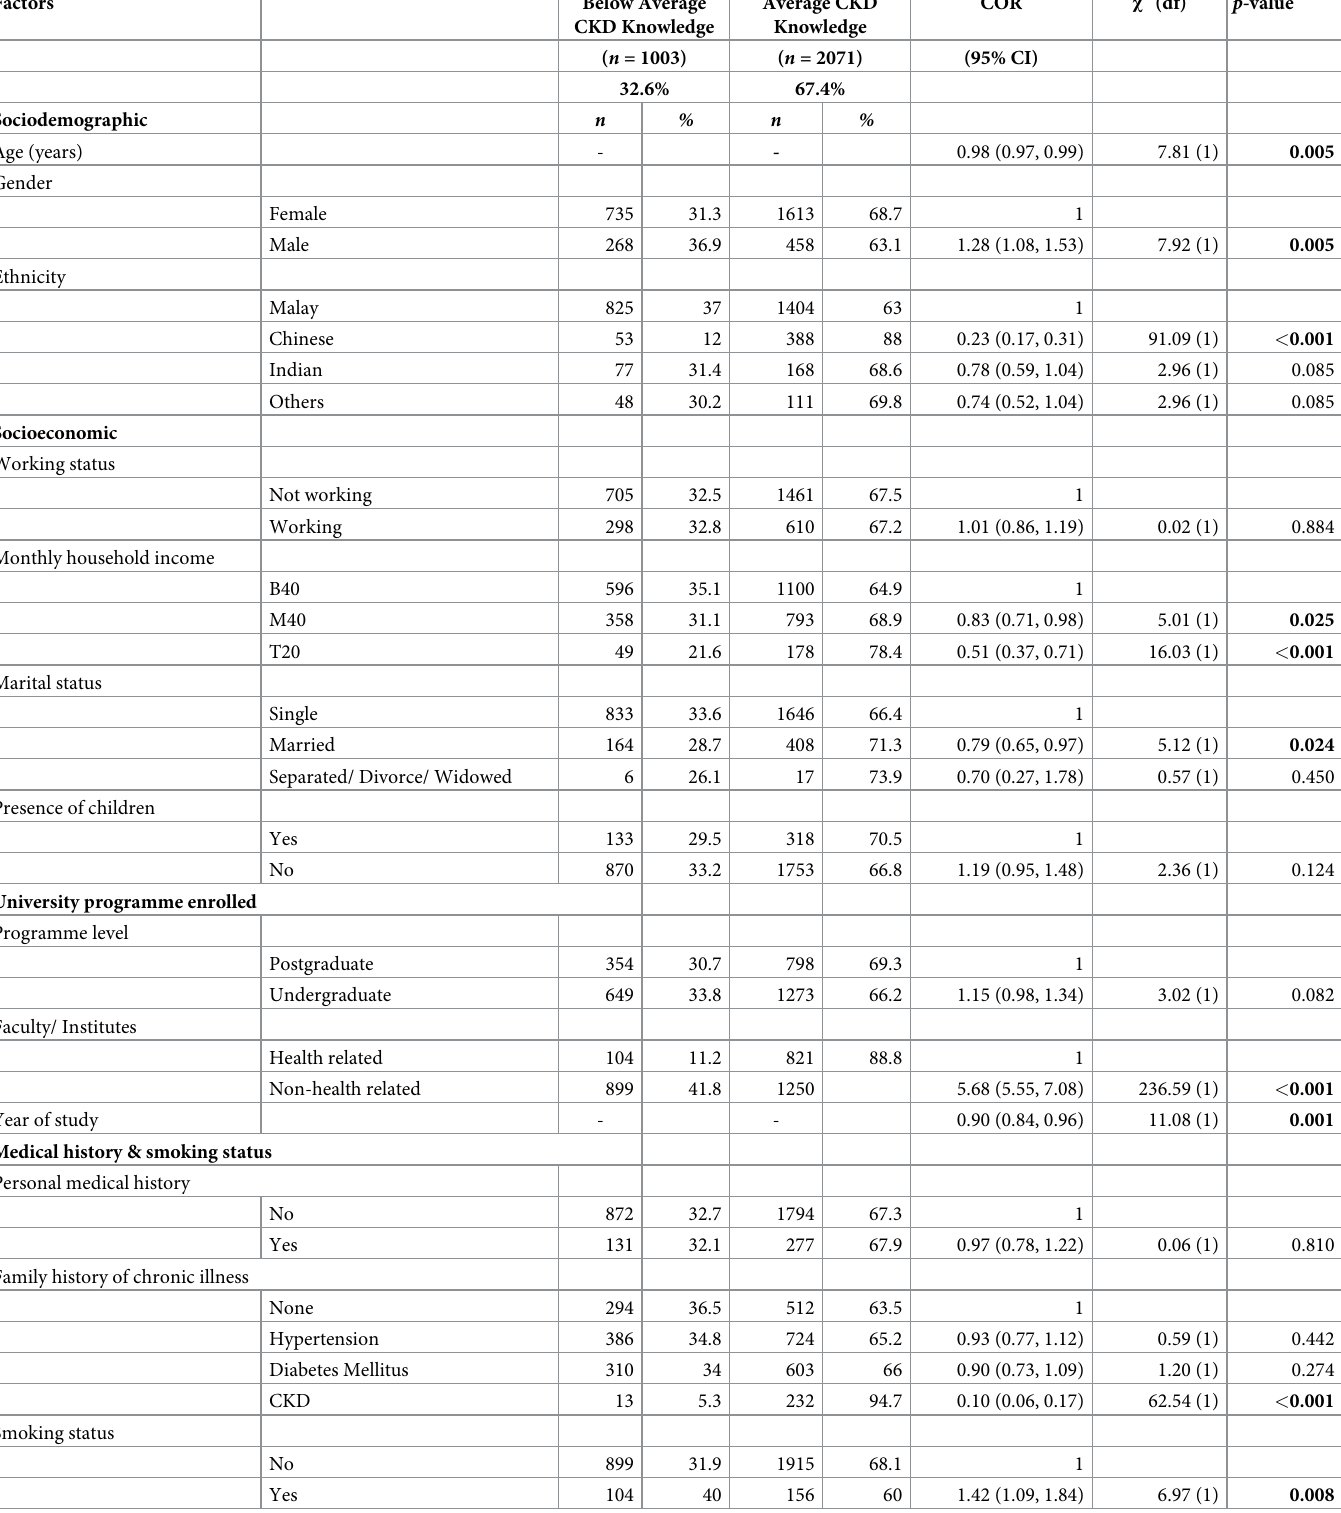
Table 2. Preliminary factors associated with CKD knowledge among students of a public university in Klang Valley, Malaysia.